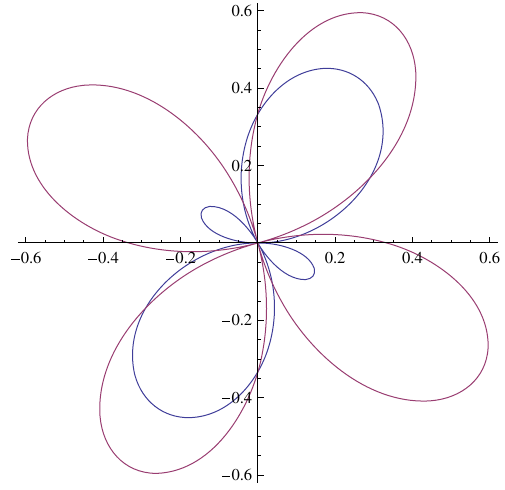
FIG. 5. Polar plots of β 2 ð θ Þ as a function of θ , with μ ¼ 0 . 5 (blue curve) and μ ¼ 2 (purple curve). β 2 ð θ Þ þ β 2 ð θ þ 2 π = 3 Þ þ β θ þ 4 π = 3 Þ is zero only when the lobes are of equal size, which 2 ð is the case for μ ¼ 2